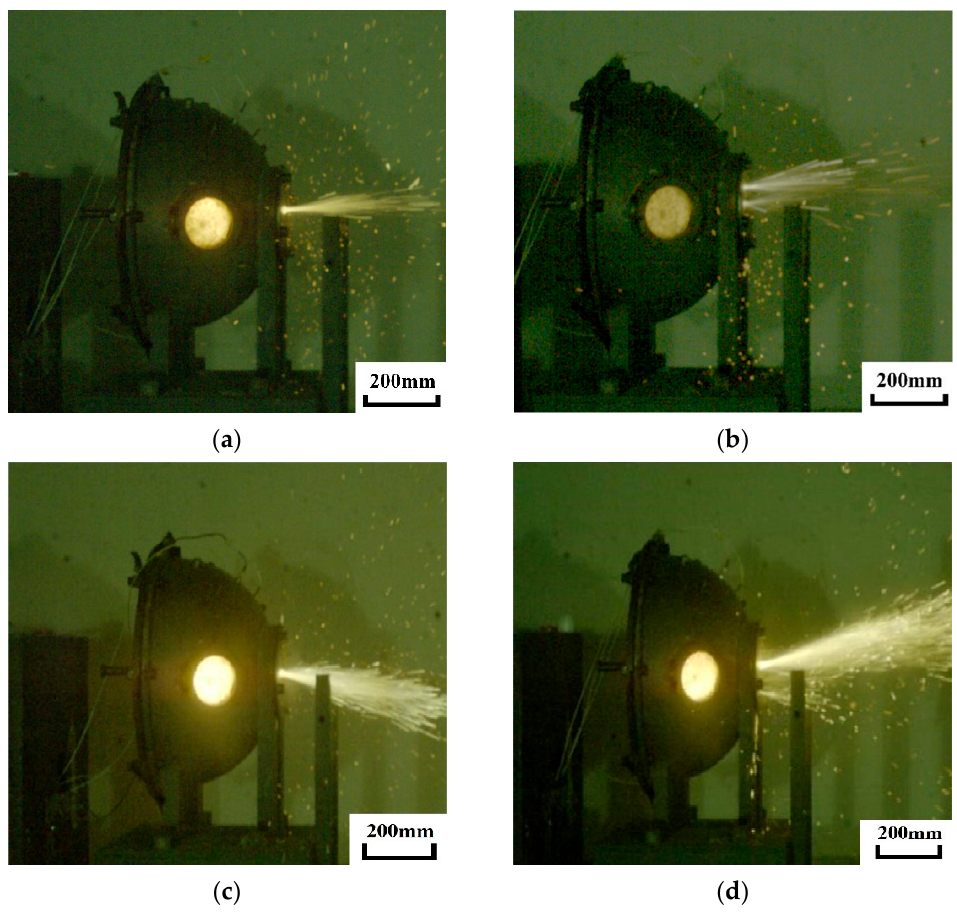
Figure 6. Video frames of Zr/PTFE and Ti/PTFE hitting the impact anvil. ( a ) Zr/PTFE: v = 970 m/s, t = 11 ms, ( b ) Ti/PTFE: v = 990 m/s, t = 16 ms, ( c ) Zr/PTFE: v = 1250 m/s, t = 10 ms, ( d ) Ti/PTFE: v = 1340 m/s, t = 18